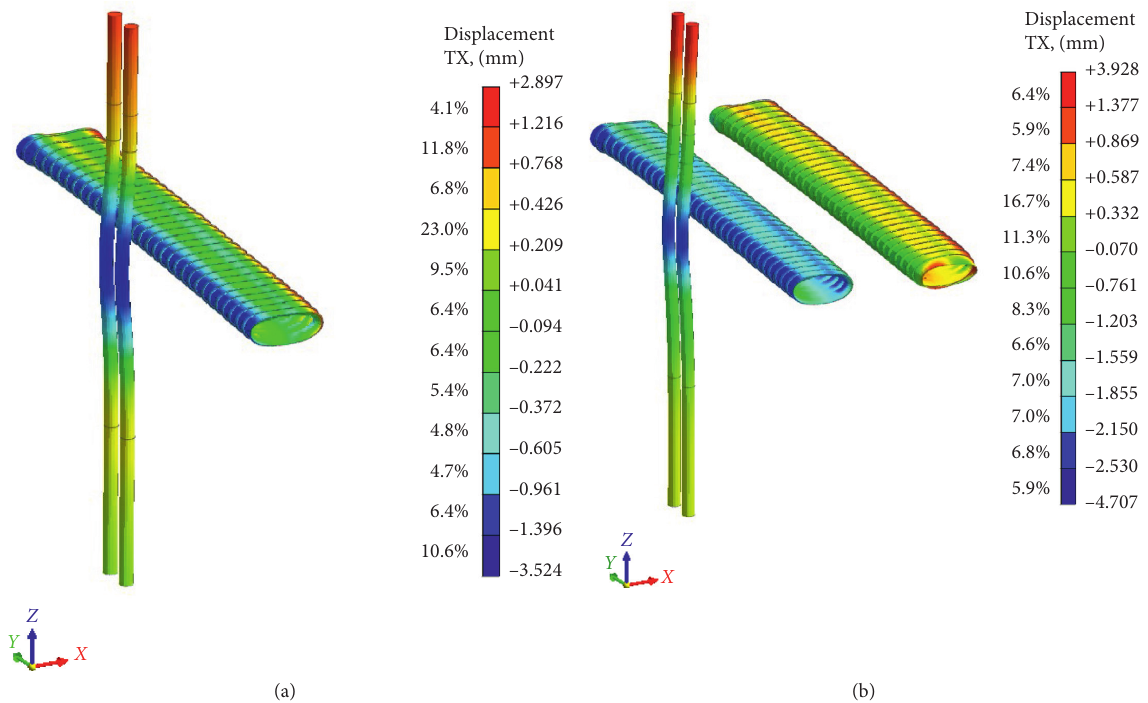
Figure 15: Horizontal displacement of pile and tunnel in condition (b). (a) Left line finished. (b) Right line